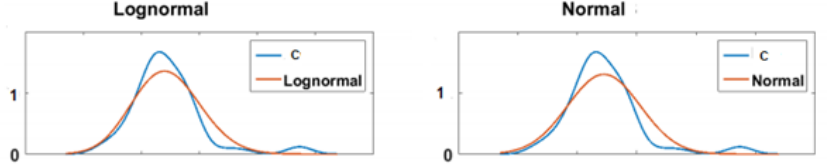
Figure 8. The normal probability density distribution of the correlation coefficient for